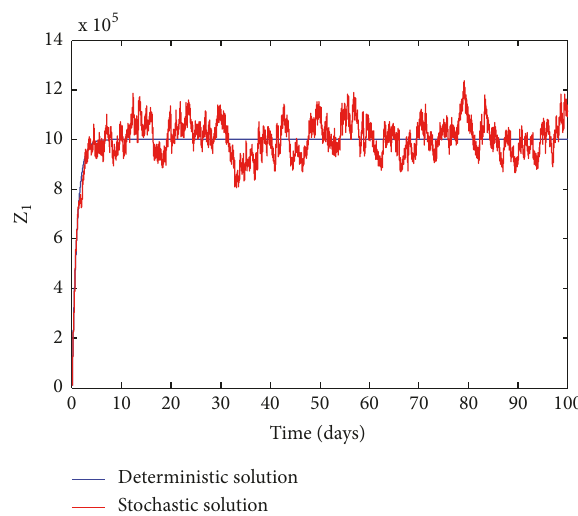
Figure 1: The approximate stationary solutions of 𝑍 1 obtained for equations (1) and (5) with 𝜎 1 = 0.5 and 𝜎 2 = 0.5 .